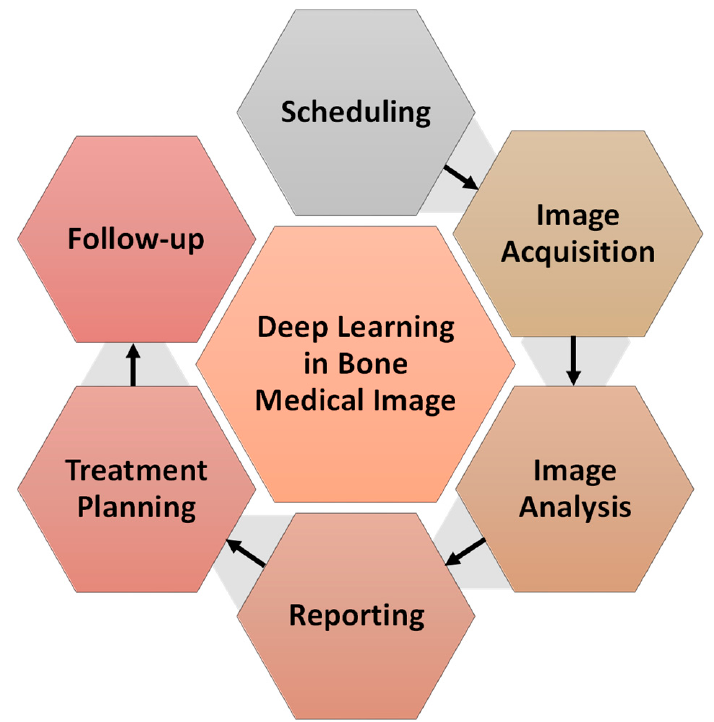
Figure 2. Illustrations of machine learning in radiology.